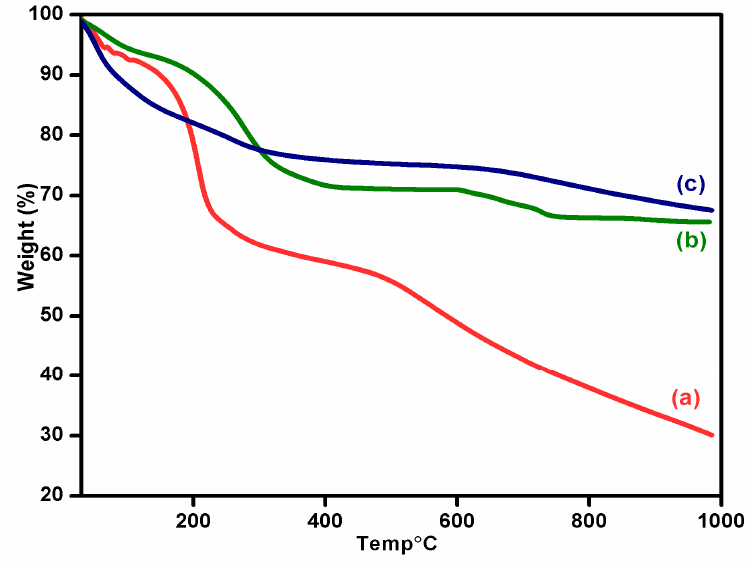
Figure 6. Thermogravimetric curves of ( a ) graphene oxide, ( b ) Nb 2 O 5 , and ( c ) Nb 2 O 5 /G nanocomposite.